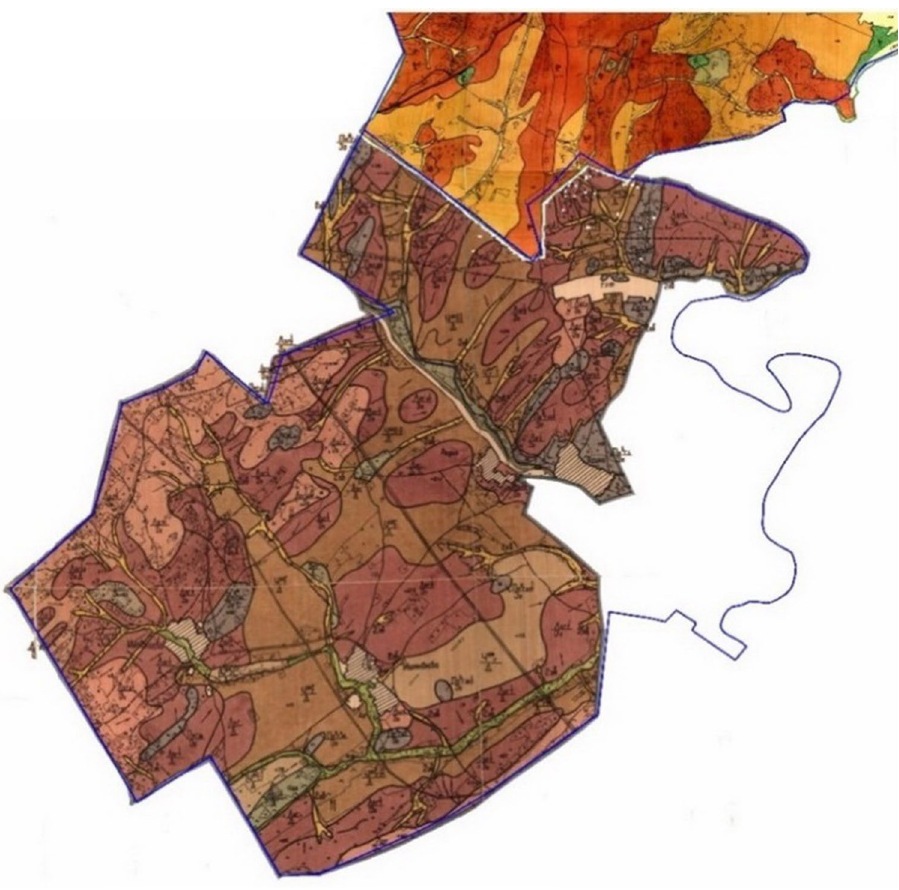
Figure 4. Soil map within the boundaries of the Salavatskiy district of the Republic of Bashkortostan,